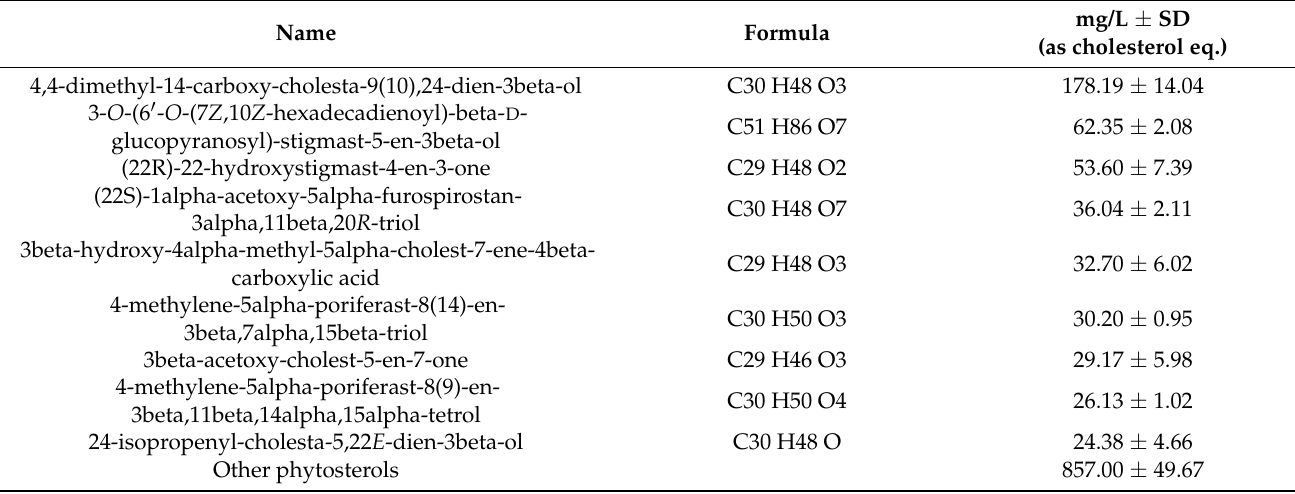
Table 2. Semi-quantification of selected phytosterols (as mg/L equivalent) detected in Gynostemma pentaphyllum (var. Ginpent)